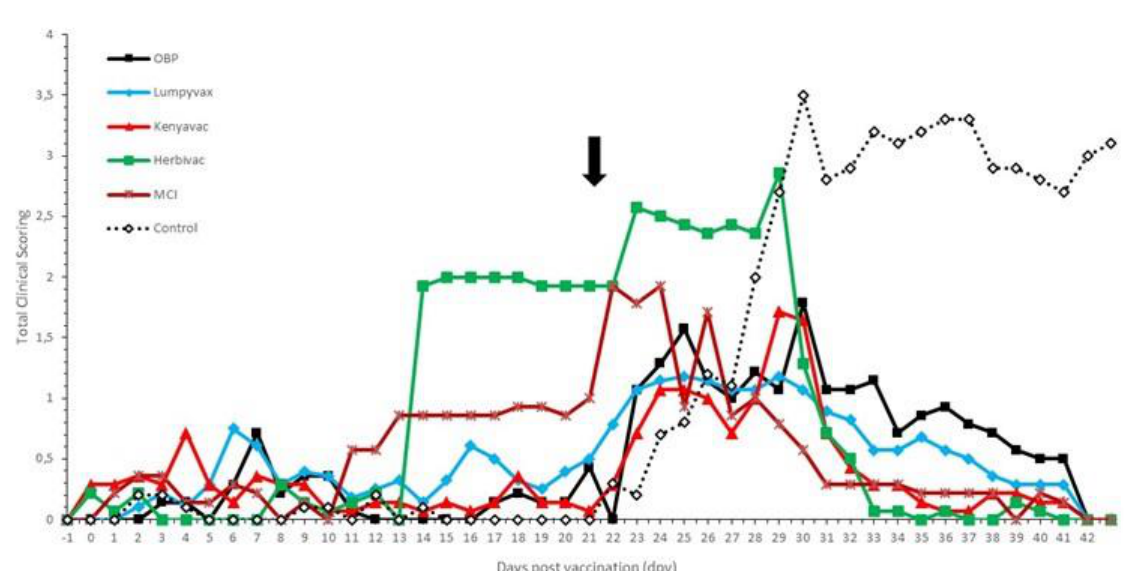
Figure 7. Averaged total clinical score of the vaccinated groups. For comparison purposes, the average of the control groups was added (dotted line). The black arrow indicates the day of challenge.